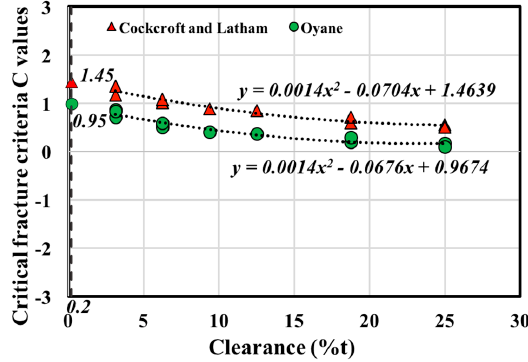
Figure 13. The values of critical ductile fracture criteria ( C ) for the Cockcroft-Latham and Oyane models obtained from polynomial equation for the clearance of 0.2 %t.